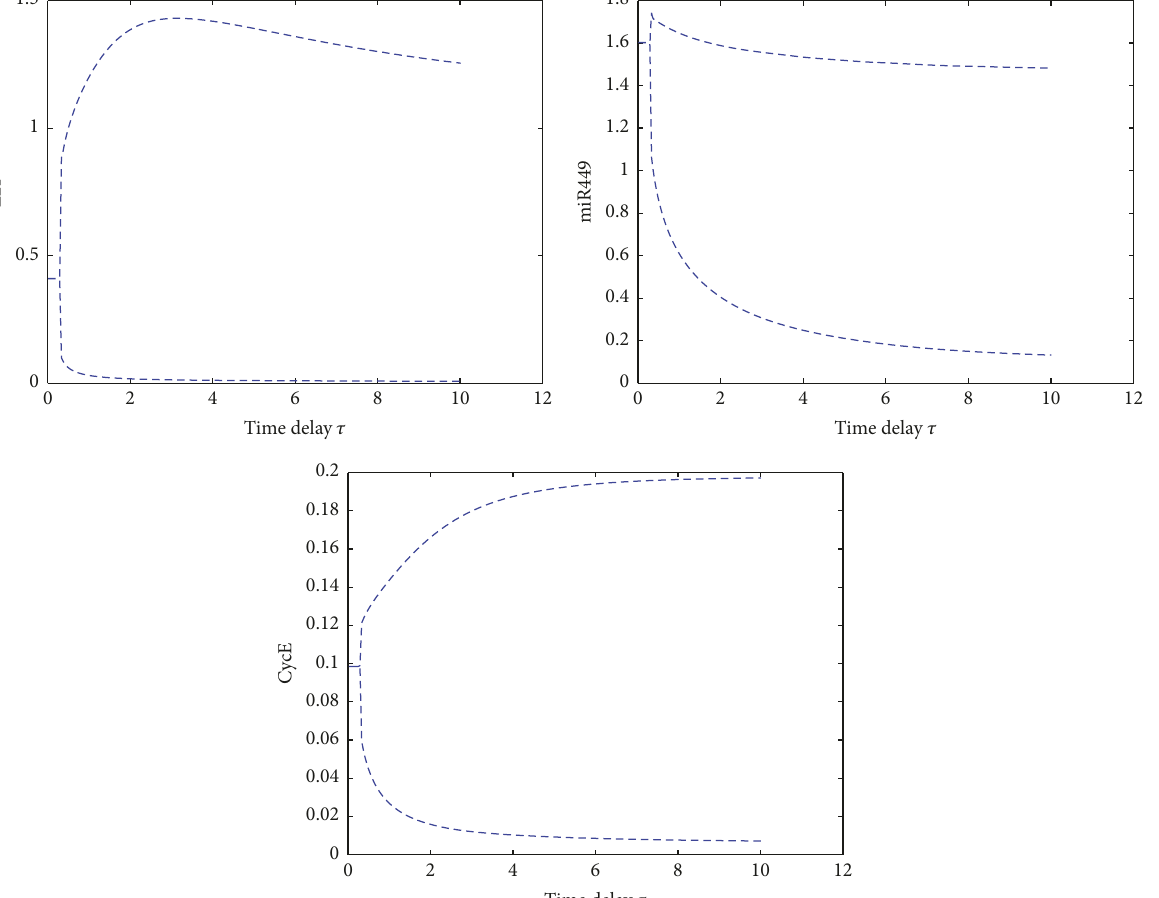
Figure 5: Bifurcation induced by time delay with 𝑆 = 5, 𝑘 21 = 1.4 . Assume initial conditions are 𝑥 1 = 1.2, 𝑥 2 = 0, 𝑥 3 = 0, 𝑥 4 = 0, 𝑥 5 = 0, 𝑥 = 0.55, 𝑥 = 0, 𝑥 = 0 , and 𝑆 = 5, 𝑘 = 1.4 6 7 8 21